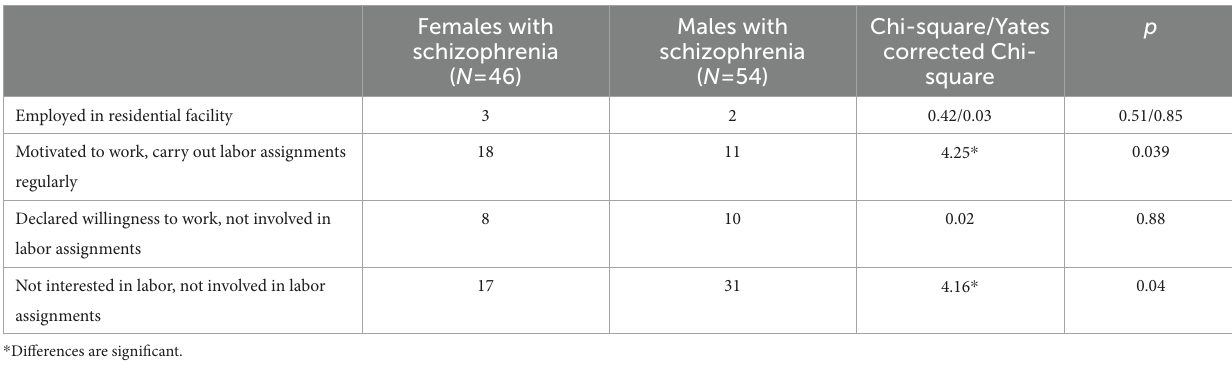
TABLE 3 Labor activity.